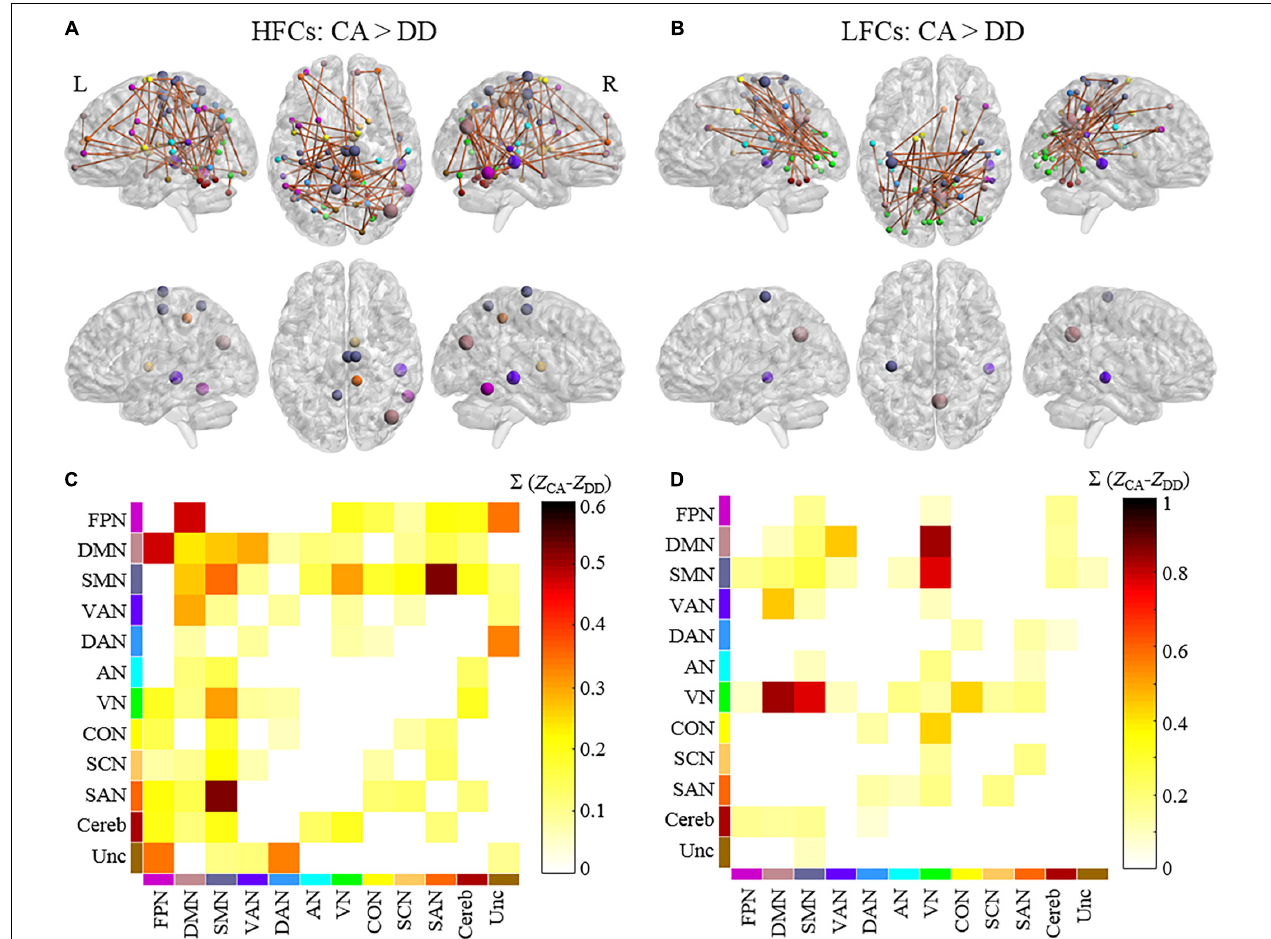
FIGURE 2 | The differences in functional brain networks between dyslexics and controls during handwriting. Brain networks and hubs of the network showing stronger connectivity in controls than in dyslexics during copying HFCs (A) and LFCs (B) . The colors of the nodes indicate the network to which they belong. The size of hubs is proportional to their node strength. The matrix plots showing the connectivity patterns within/between each pair of networks during copying HFCs (C) and LFCs (D) . The color of each element in the matrices represents the sum of the differences in connectivity strength of all the edges for the connected networks. L = left and R = right. HFCs = high-frequency characters, LFCs = low-frequency characters, DD = developmental dyslexia, CA = chronological-age matched control group. FPN = frontal-parietal network, DMN = default mode network, SMN = somatomotor network, VAN = ventral attention network, DAN = dorsal attention network, AN = auditory network, VN = visual network, CON = cingulo-opercular network, SCN = subcortical network, SAN = salience network, Cereb = cerebellum and Unc =